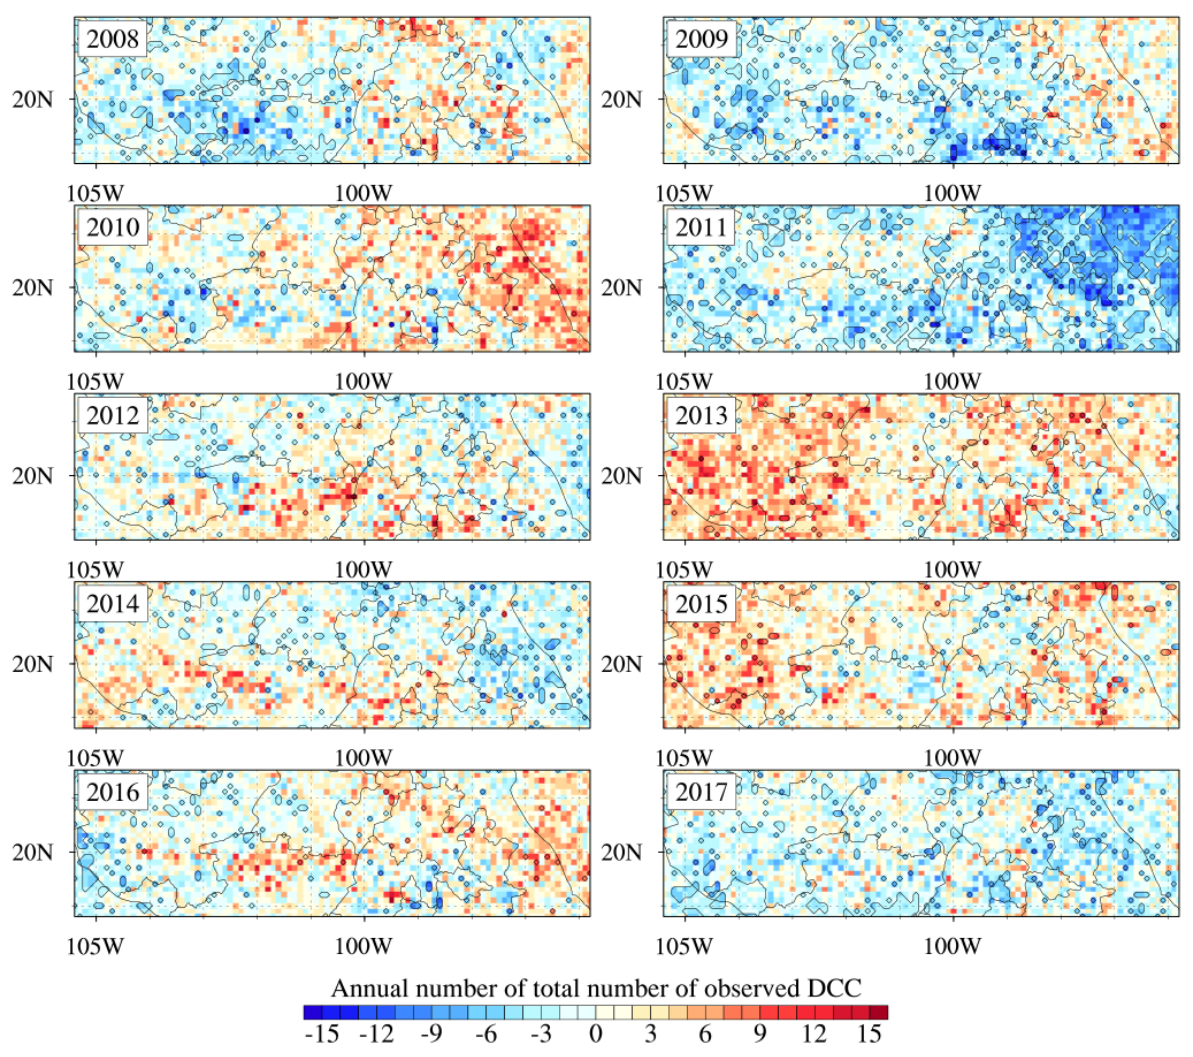
Figure 9. Annual anomaly of the total number of observed deep convective clouds (2008–2017) based on MODIS cloud data, with a horizontal resolution of 0.1 degrees. The black lines indicate the grid boxes with a significant